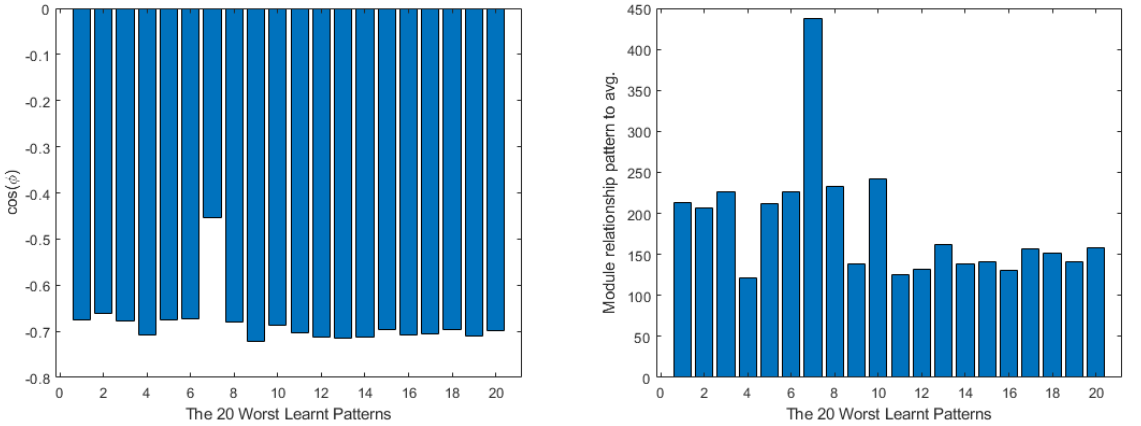
(cid:12) (cid:12) 𝜕𝐿𝑜𝑠𝑠 ∂ Loss (cid:12) (cid:12) | relationship to the average (cid:12) (cid:12) relationship to the average ∂ W n 𝜕𝑊 𝑛